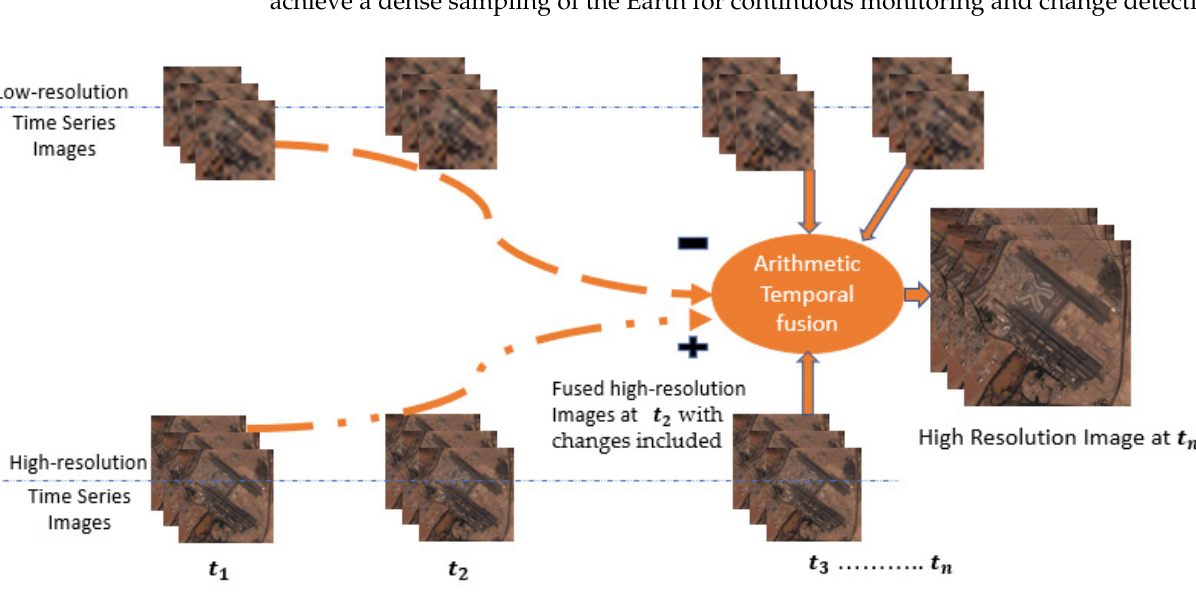
Figure 1. Our proposed remote sensing image fusion approach.